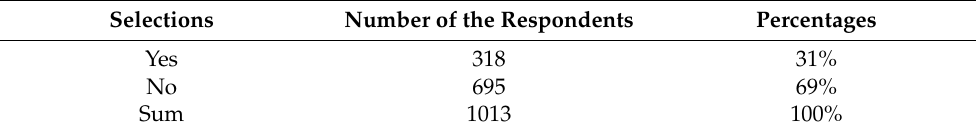
Table A6. Do you have any experiences on holdings of cryptocurrencies (single-choice question)?